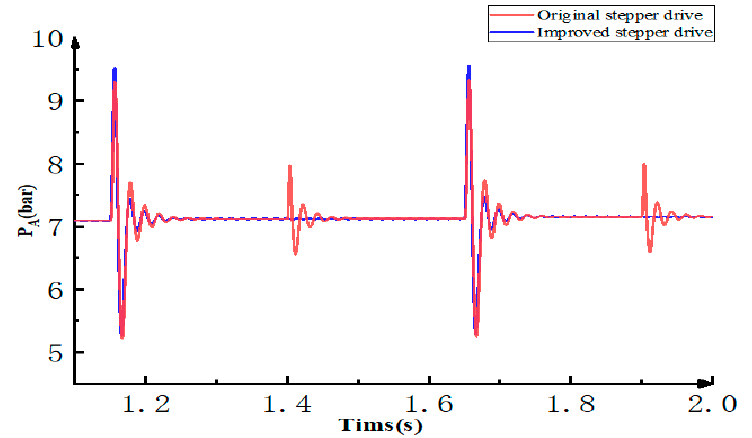
Figure 10. The pressure fluctuation of the oil inlet A of the actuator hydraulic cylinder.